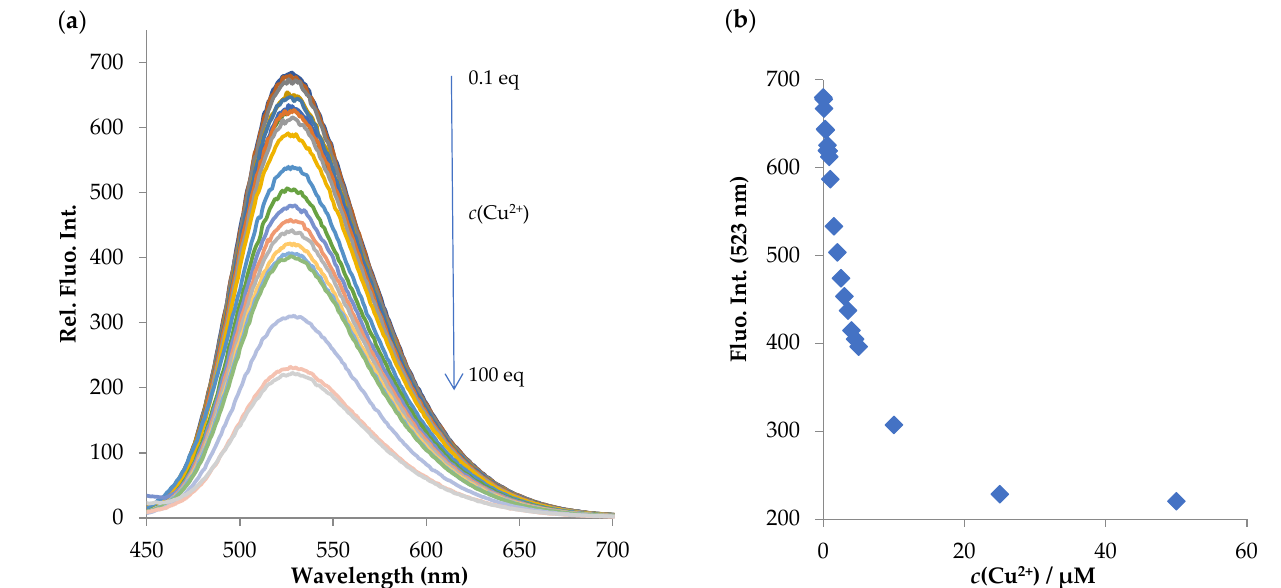
Figure 6. ( a ) Fluorescence titration spectra of NI-1 ( c = 5.00 × 10 − 7 M) in the presence of changing concentration of Cu 2+ ions ( c (Cu 2+ ) = 5.00 × 10 − 8 M–5.00 × 10 − 5 M, as shown in the graph ranging from 0.1 eq to 100 eq) in MeOH/buffer (v/v, 1/2, pH = 5.5), λ exc = 410 nm. ( b ) Plot of fluorescence quenching at 523 nm of NI-1 as a function of Cu 2+ ion concentration.